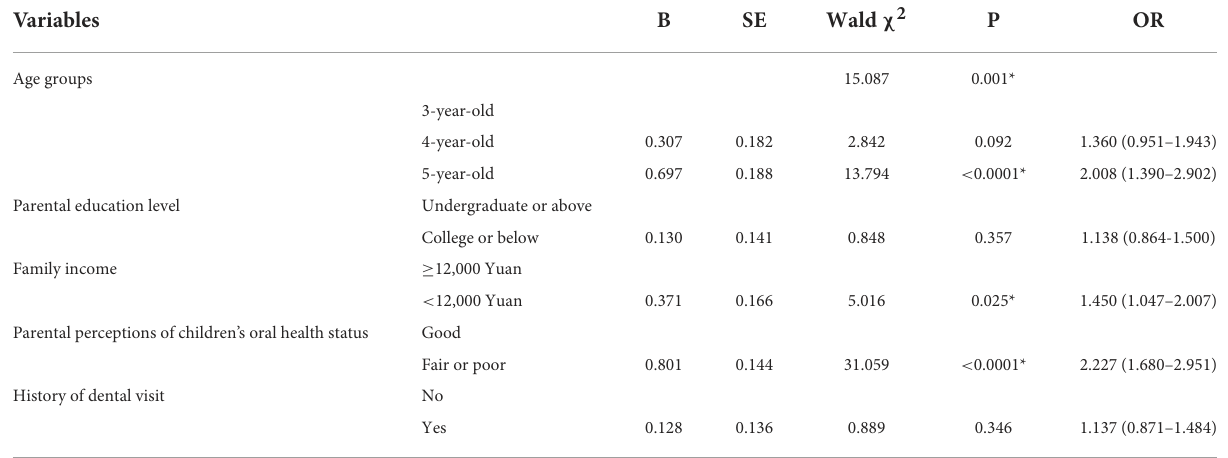
TABLE 4 Logistic regression analysis of factors associated with the ECC